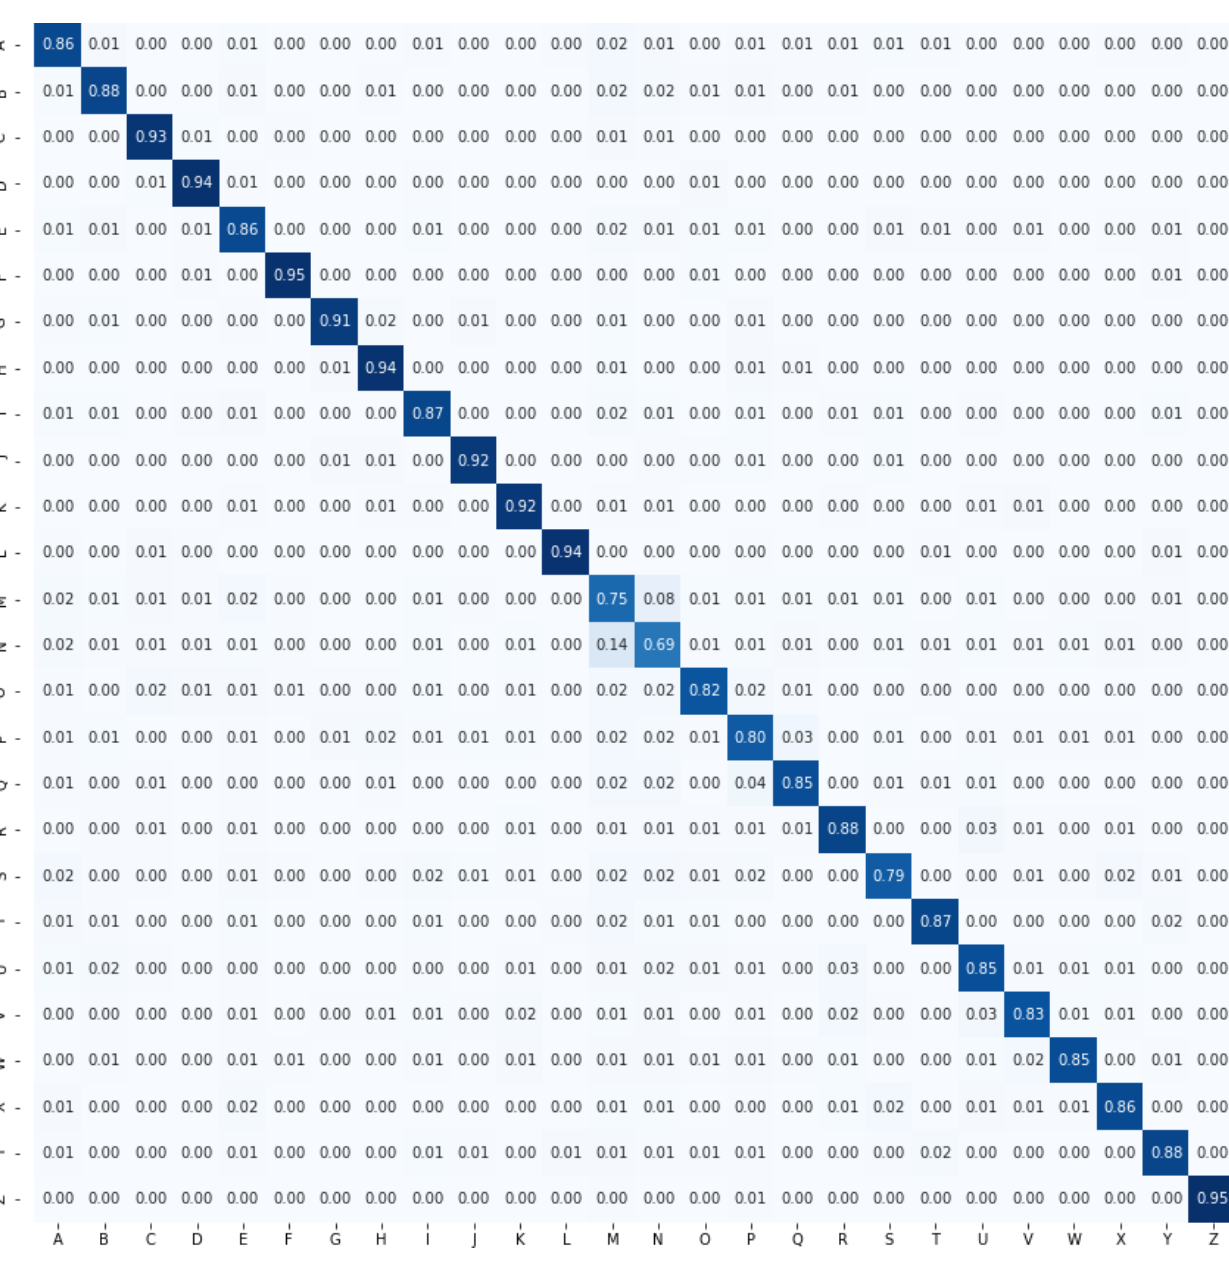
Figure 8. Confusion matrix for angle-based